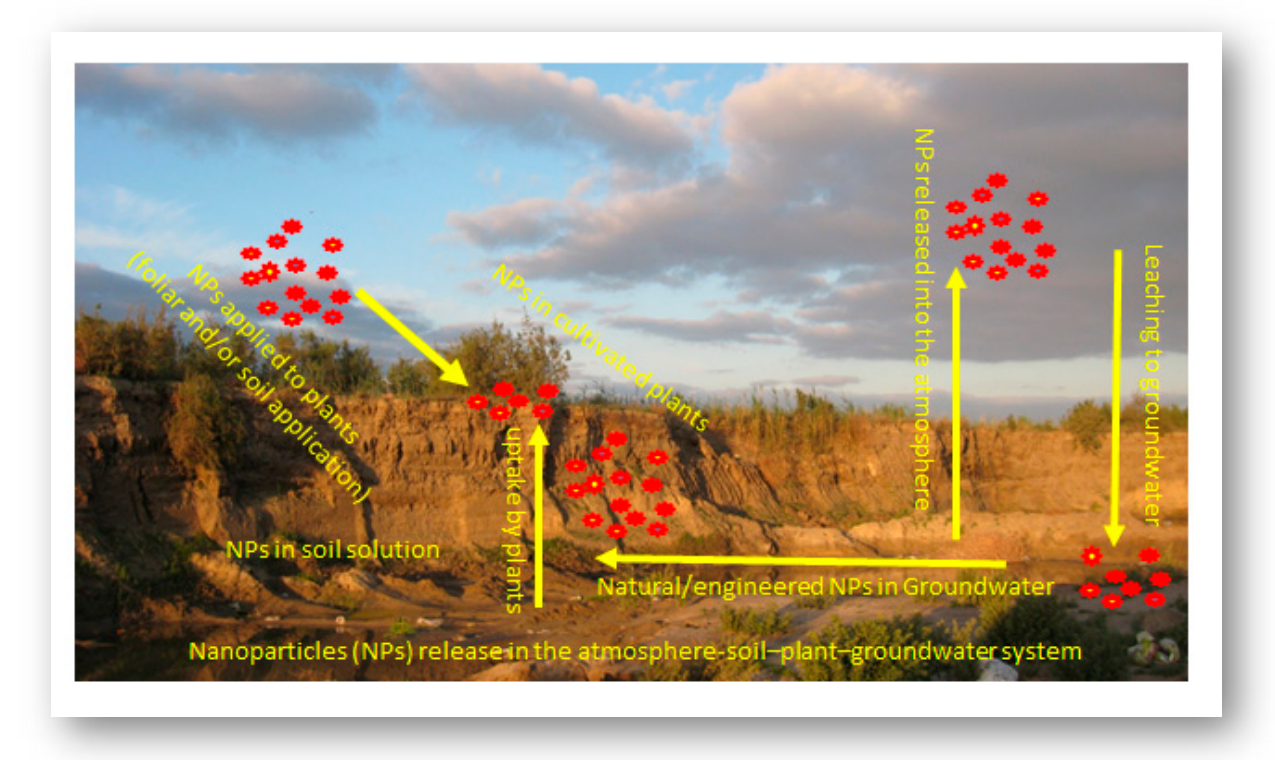
Figure 16. The fate and behavior of nanoparticles (NPs) released into the atmosphere–soil–plant– groundwater system (adapted from [128]).